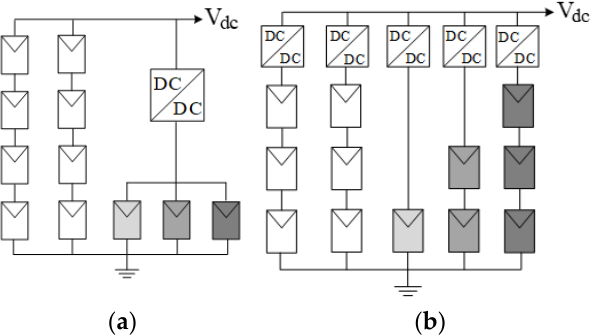
Figure 8. String-Configured Dynamic PV Array ( a ) [23]; the Optimized String-Configured Dynamic PV Array ( b )